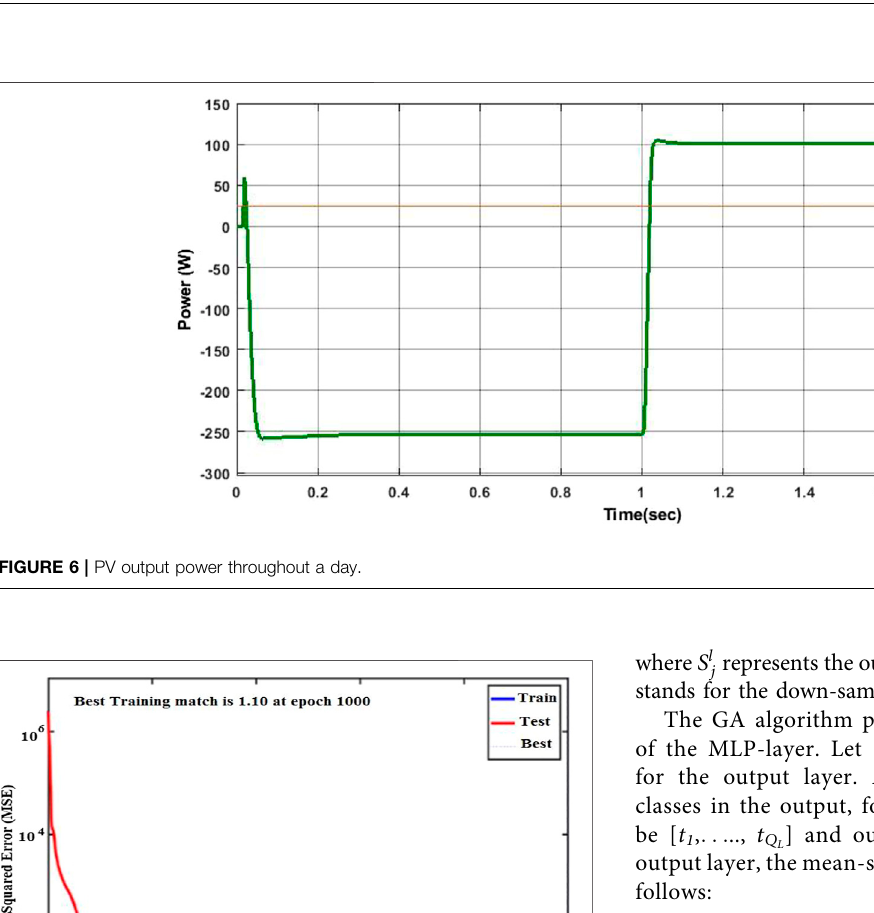
FIGURE 5 | Wind turbine output power throughout a day.